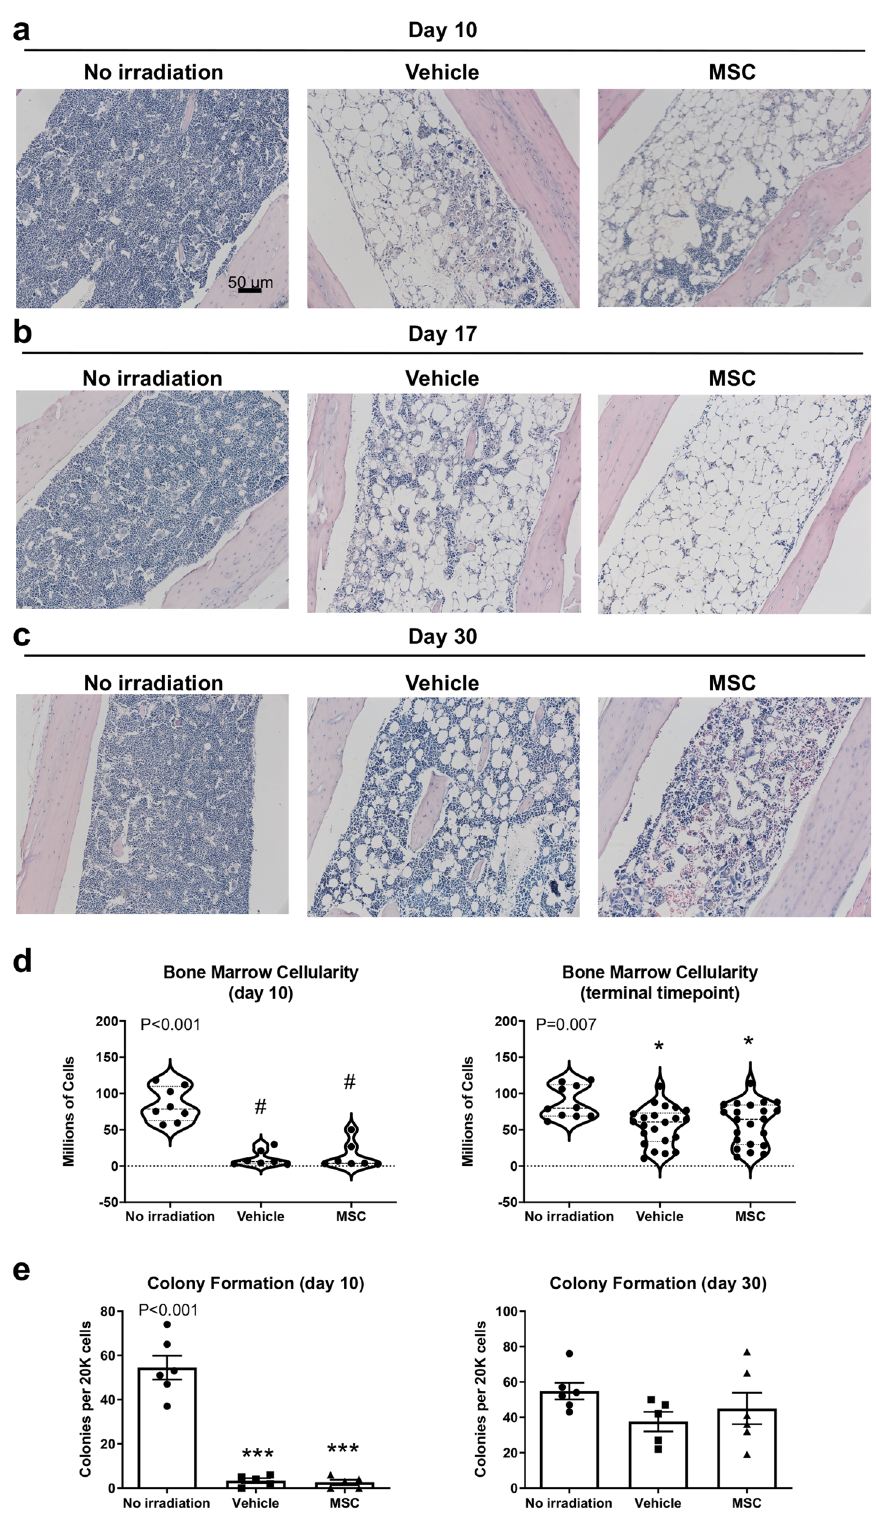
Figure 3. Bone marrow hypocellularity and architectural disruption is not abrogated by MSC therapy. ( a ) In the proximal tibia, extensive marrow aplasia and adipocytic expansion recognizable as empty round vacuoles are apparent 10 days after injury by H&E staining. ( b ) Mice that died between 14 and 17 days post-radiation exhibited severe hypocellularity of the bone marrow. Histopathology of two mice that died at day 17 suggests little evidence of hematologic recovery in the marrow. ( c ) Marrow is partially restored in surviving mice at day 30. ( d ) Recovery from aplasia was variable but largely reflected incomplete regeneration of the marrow at the study end point at 30 days. ( e ) CFU activity of whole bone marrow cells. Statistical significance of differences between groups is depicted on the graphs. Posthoc comparisons are demarcated by asterisks * P < 0.05 and *** P < 0.001 for Holm–Sidak (One-way ANOVA) or pound symbol # P < 0.5 for Dunn’s (Kruskal–Wallis One-way ANOVA) analyses relative to No irradiation